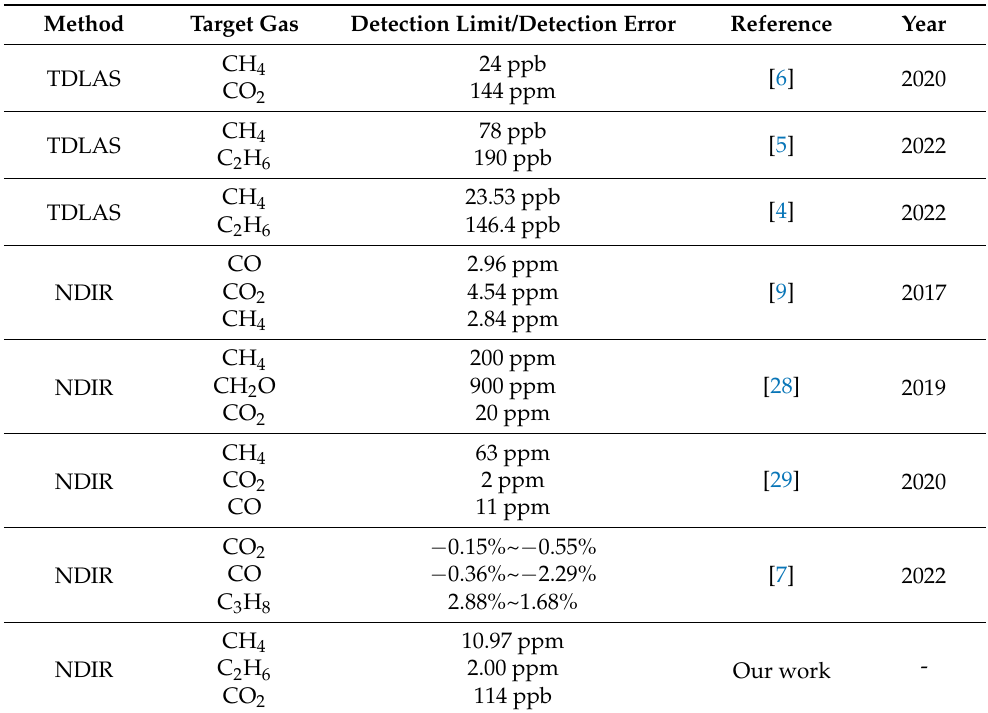
Table 1. Summary of related work using infrared absorption spectroscopy to measure CH 4 , C 2 H 6 , and CO 2